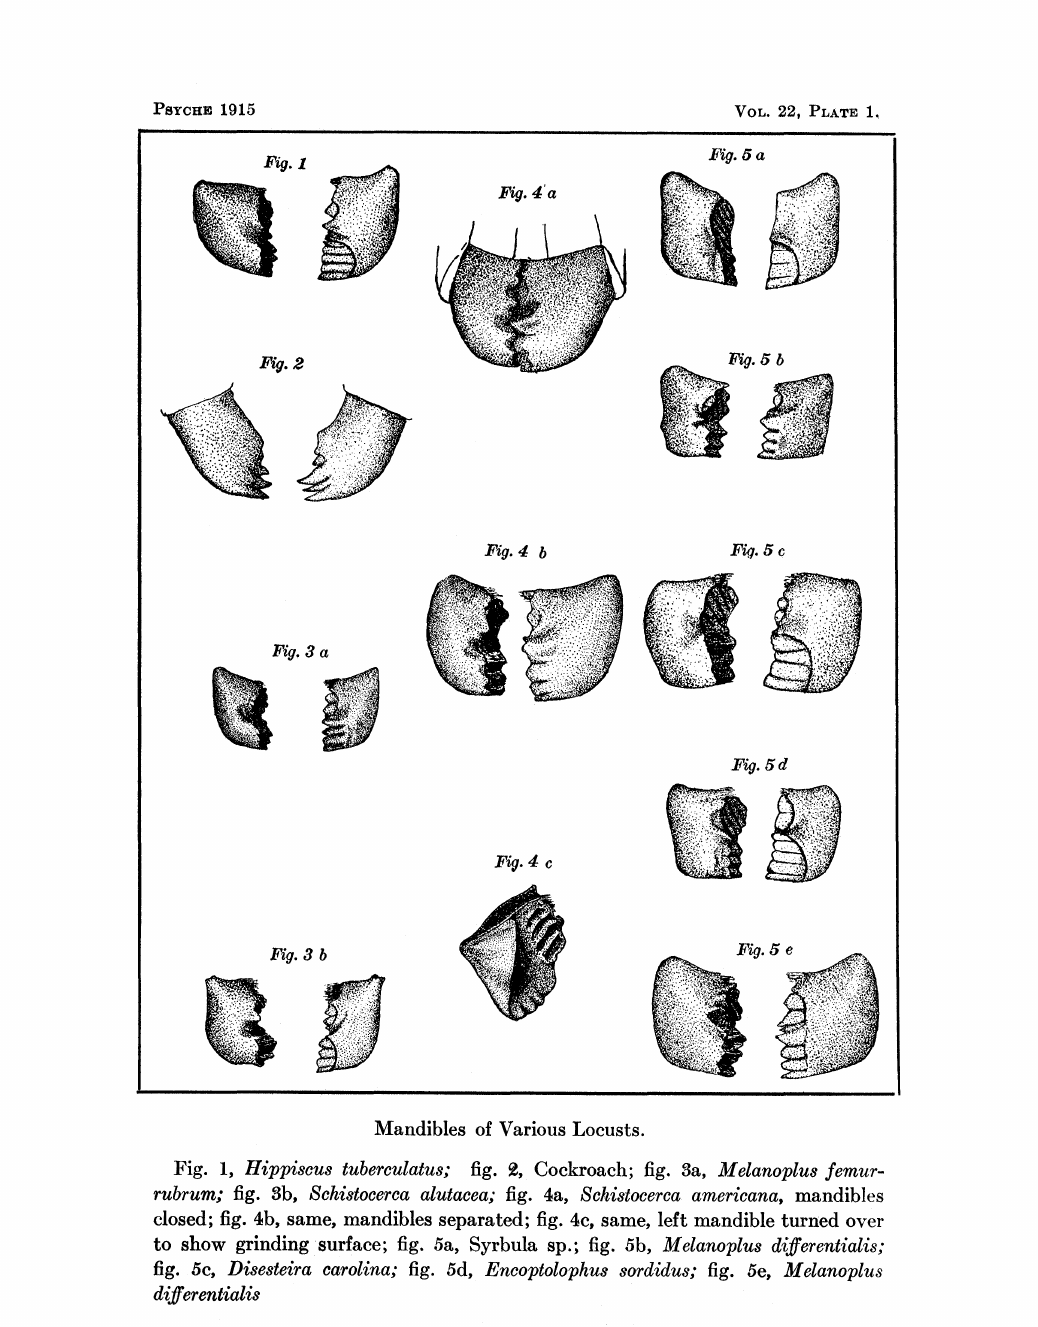
, Mandibles of Various Locusts. Fig. 1, Hippiscus tuberculatus; fig. Cockroach; fig. 3a, Melanoplus femur- rubrum; fig. 8b, Schistocerca alutacea; fig. 4a, Schistocerca americana, mandibles closed; fig. 4b, same, mandibles separated; fig. 4c, same, left mandible turned over to show grinding surface; fig. 5a, Syrbula sp.; fig. 5b, Melanoplus differentialis; fig. 5c, Disesteira carolina; fig. 5d, Encoptolophus sordidus; fig. 5e, Melanoplus di ff